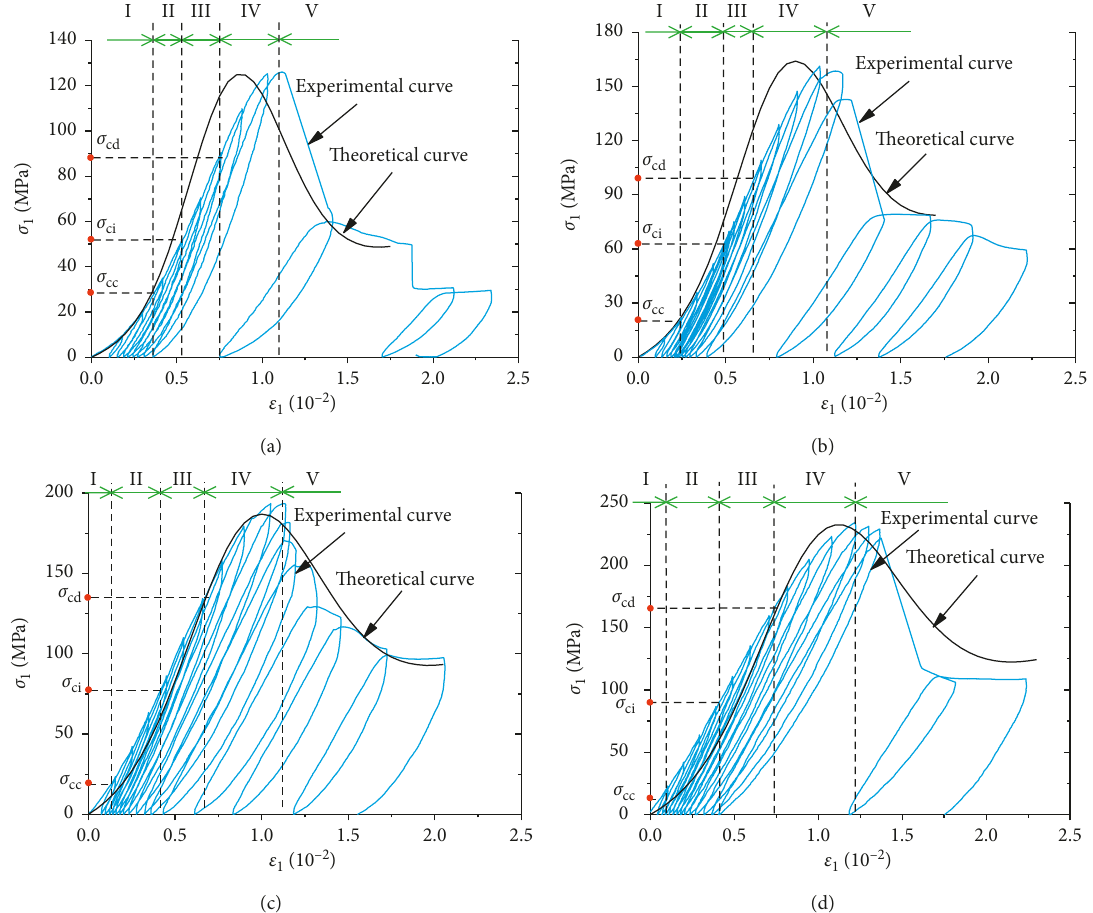
Figure 13: Theoretical stress-strain curves based on energy proportion with the confining pressures of 5MPa (a), 10MPa (b), 20MPa (c), and 30MPa